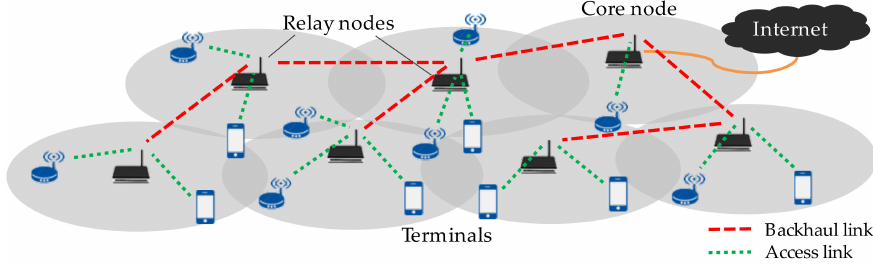
Figure 1. Multi-hop wireless backhaul